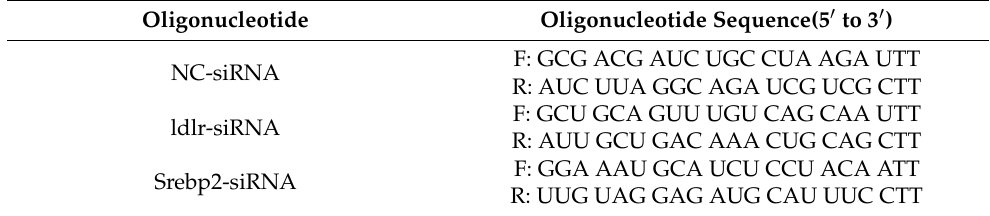
Table 2. The information of oligonucleotide.